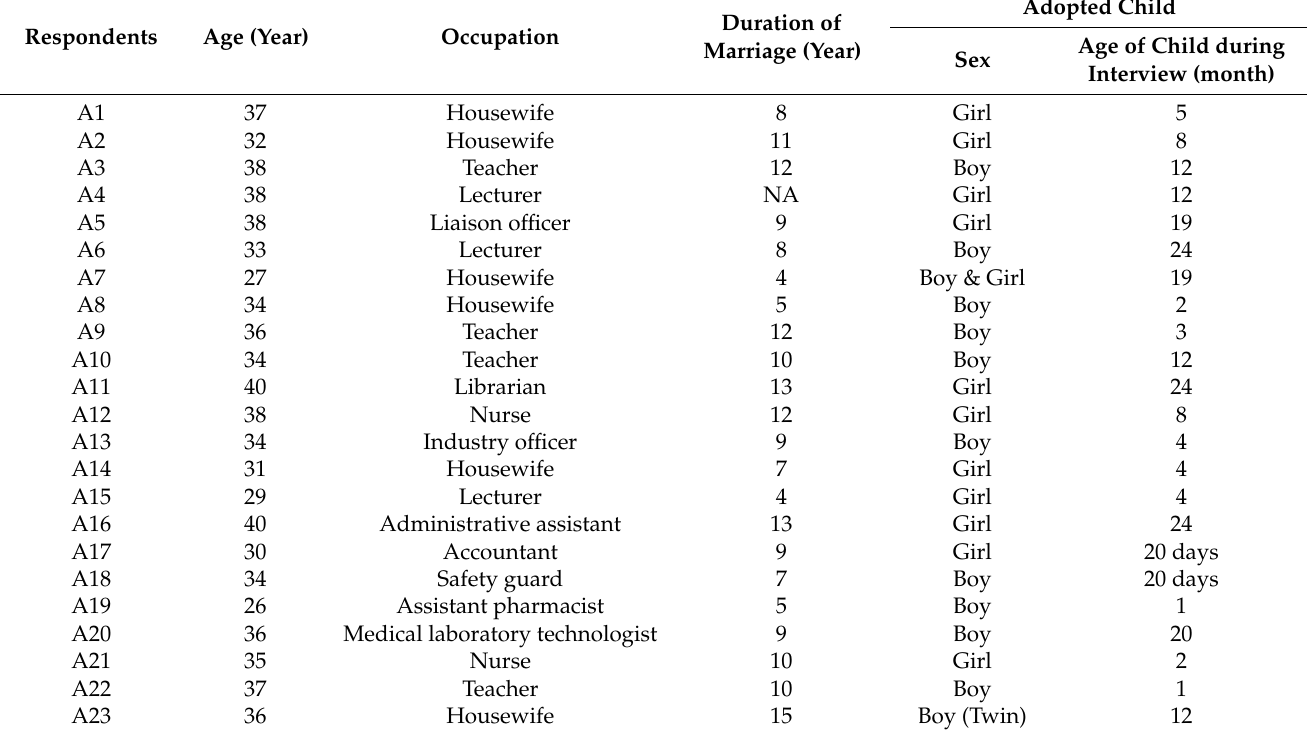
Table 1. Descriptive characteristics of